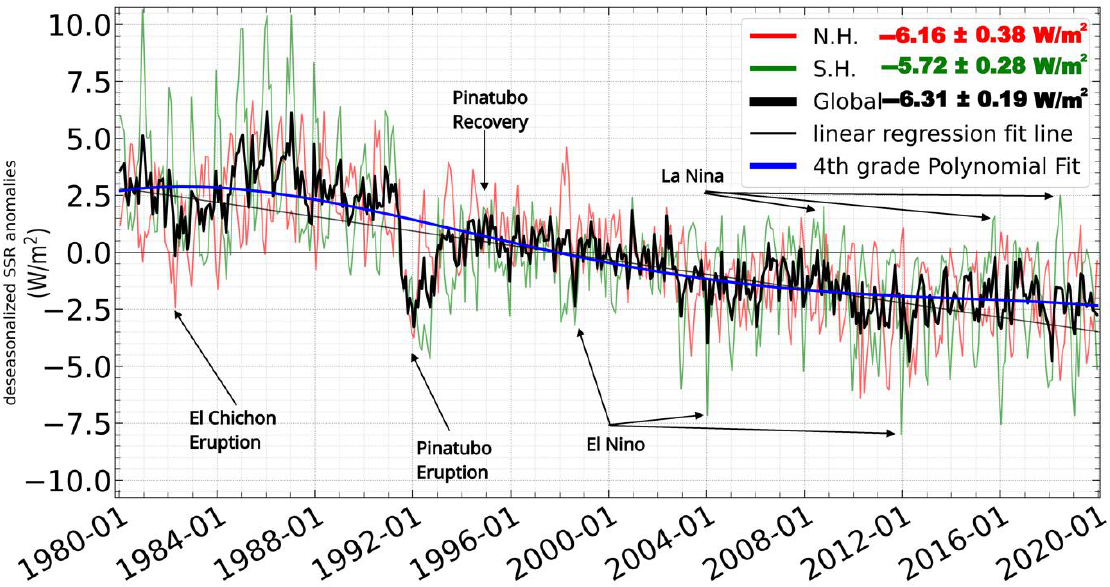
Figure 12. Timeseries of MERRA-2 average global (black line) and hemispherical (NH and SH, red and green lines) monthly mean deseasonalized SSR anomalies for the period January 1980 – December 2019. Linear regression fit line, along with the associated Δ (SSR) for the Globe and the two hemispheres (numbers in the embedded panel), as well as the 4th-order polynomial fit applied to the global time series of MERRA-2 SSR, are also shown.